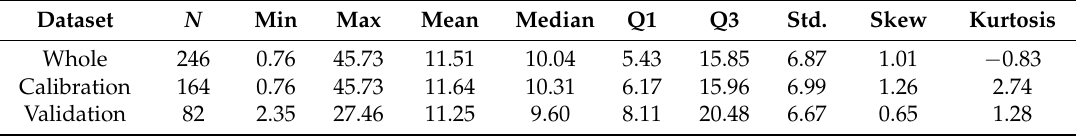
Table 1. Statistical description of the soil organic carbon (SOC) contents (g · kg − 1 ) of soil samples. Dataset